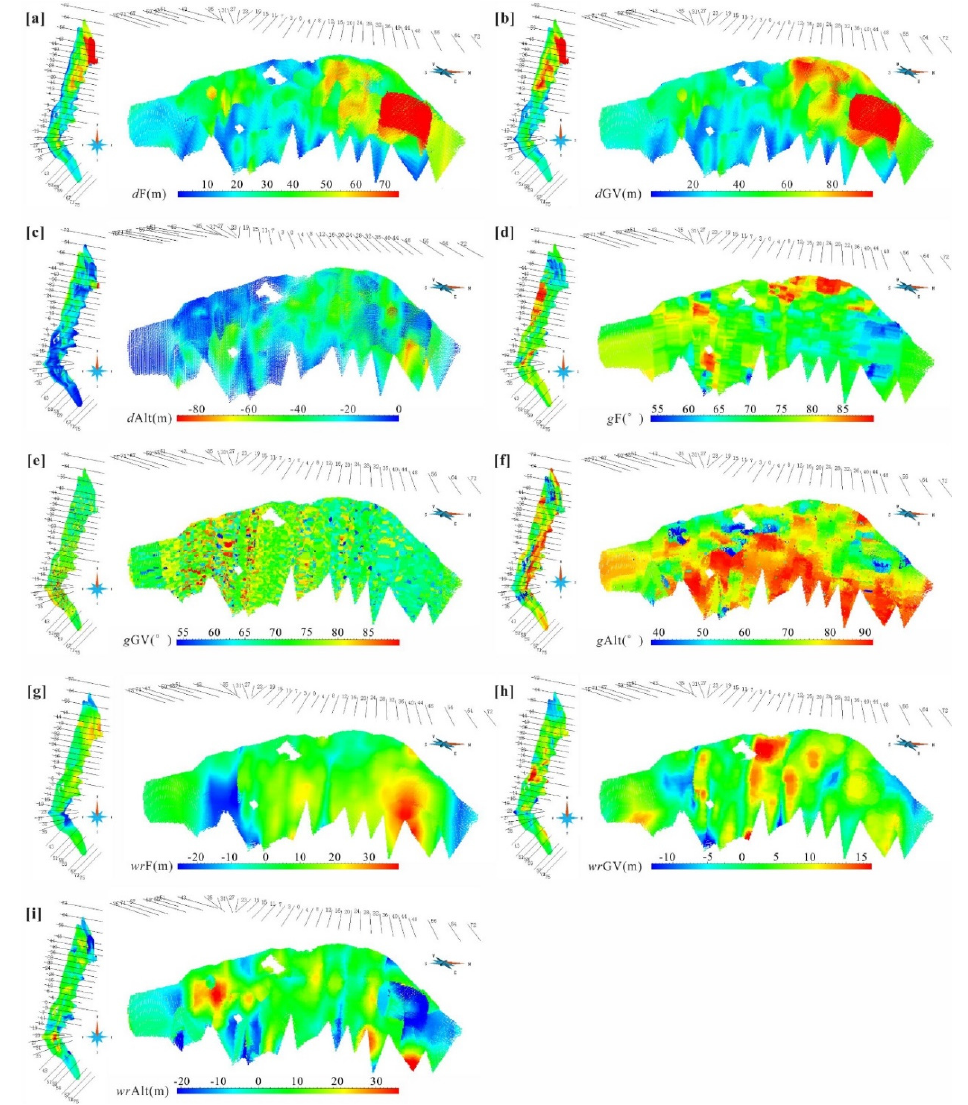
Figure 6. Above; 3D raster models showing the distribution of geological features of the Axi deposit. ( a ) d F (distance value to F 2 ); ( b ) d GV (distance value to the lower interface of LVP); ( c ) d Alt (distance value to the upper interface of the phyllic alteration zone); ( d ) g F (slope of F 2 ); ( e ) g GV (slope of the lower interface of LVP); ( f ) g Alt (slope of the upper interface of the phyllic alteration zone); ( g ) wr F (undulation of F 2 ); ( h ) wr GV (undulation of the lower interface of LVP); and ( i ) wr Alt (undulation of the upper interface of the phyllic alteration